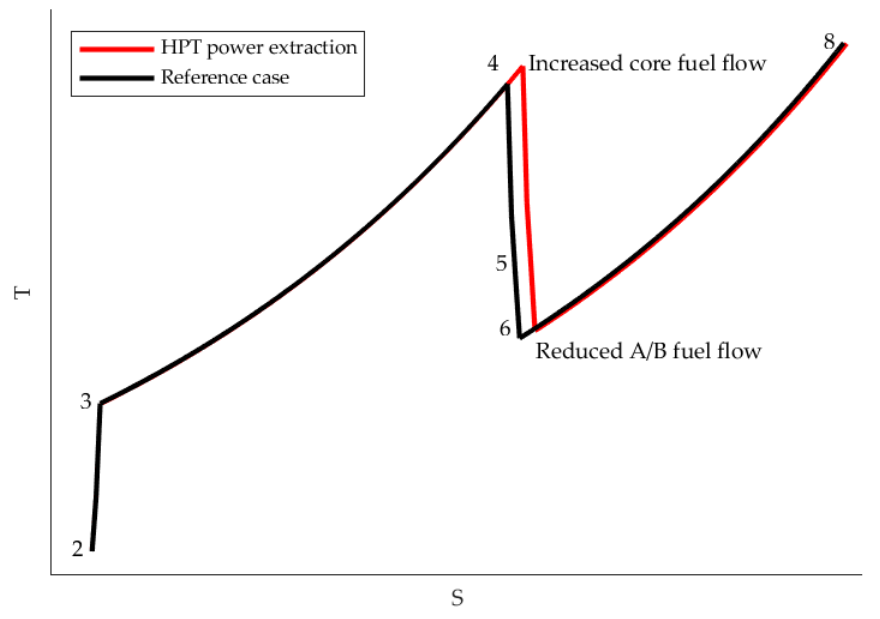
Figure 7. Core, afterburner and total fuel flow deviation with HPT power extraction compared to the reference case.